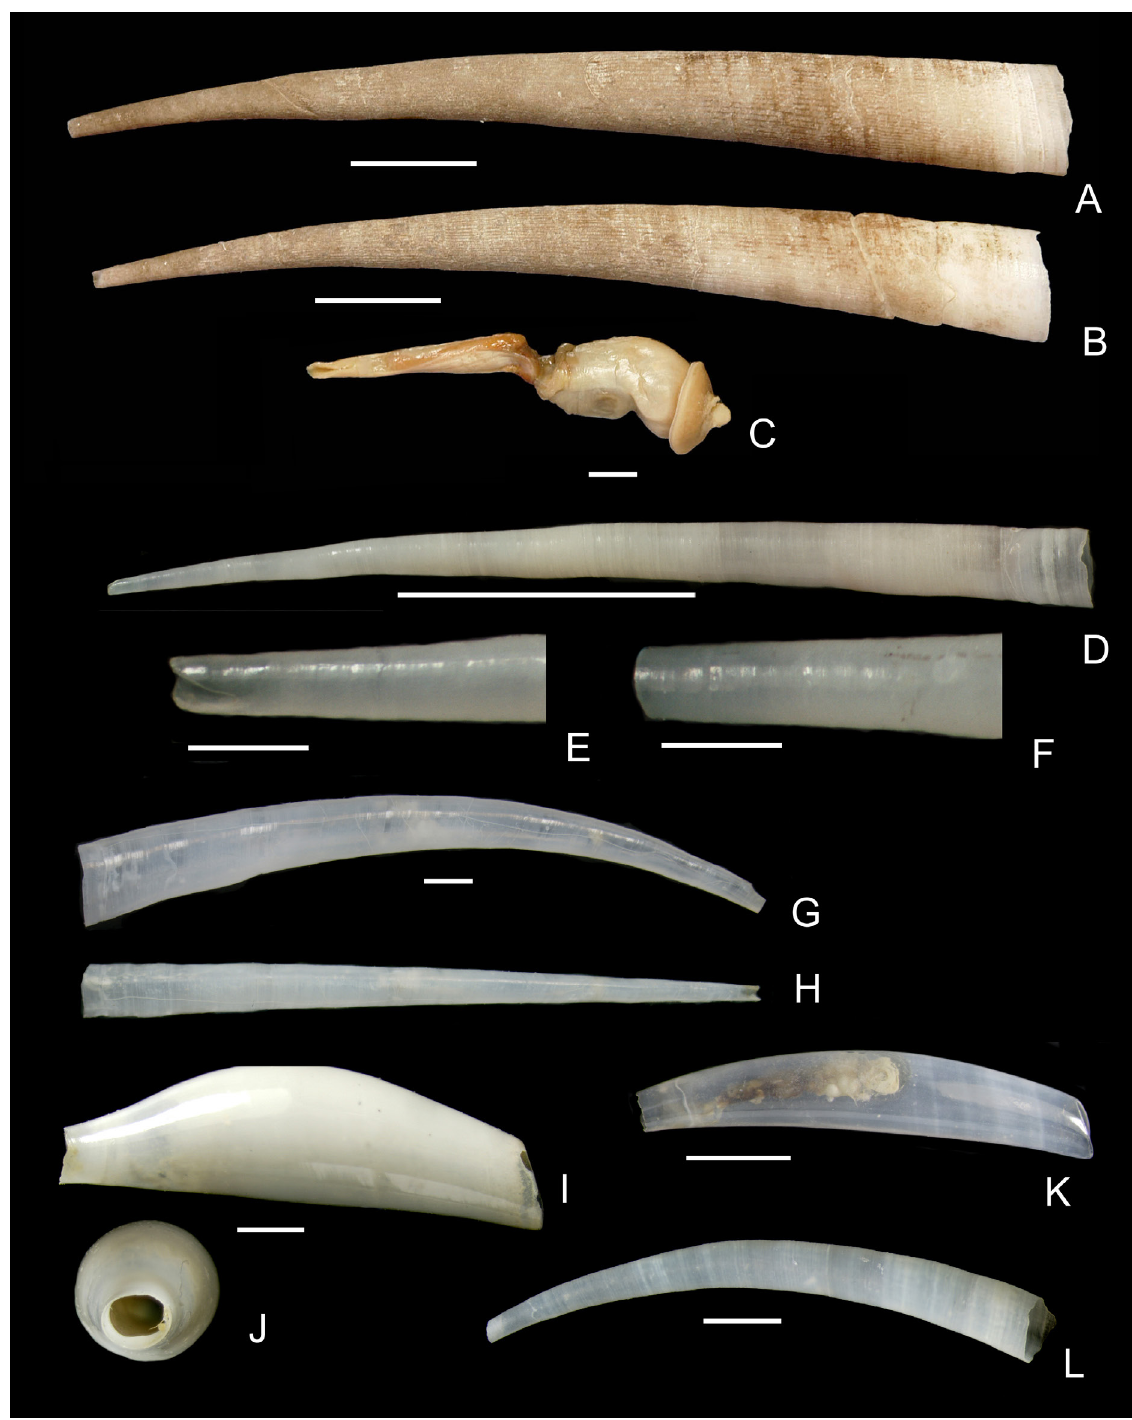
Fig. 44. Scaphopoda. A–C . Fissidentalium capillosum (Jeffreys, 1877), shell and soft parts, BANGAL 0711, V2, 1706 m, shells 80 and 74 mm. D–F . Antalis agilis (M. Sars in G.O. Sars, 1872), ECOMARG 0709, V5, 876 m, 32.8 mm and details of the posterior end. G–H . Bathoxiphus ensiculus (Jeffreys, 1877), BANGAL 0711, V5, 1631 m, 14.0 mm. I–J . Cadulus monterosatoi Locard, 1897, BANGAL 0711, V9, 1671 m, 7.2 mm. K . Cadulus artatus Locard, 1897. BANGAL 0711, V2, 4.3 mm. L . Pulsellum lofotense (M. Sars, 1865), BANGAL 0711, V2, 7.1 mm. Scale bars: A–D = 10 mm; E–L = 1